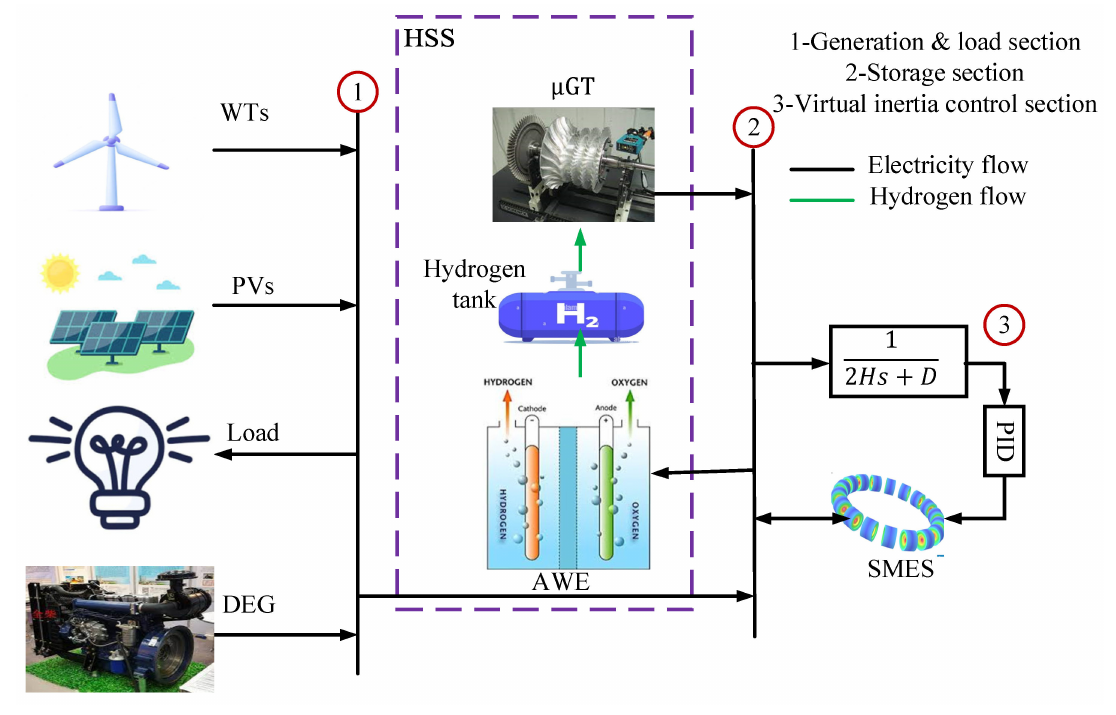
Figure 1. The studied microgrid.